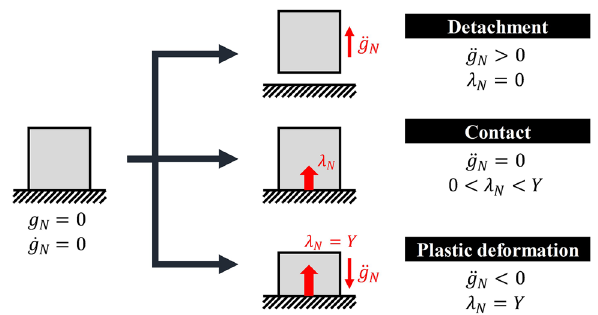
Fig. 6 State transitions 1 for detachment and plastic